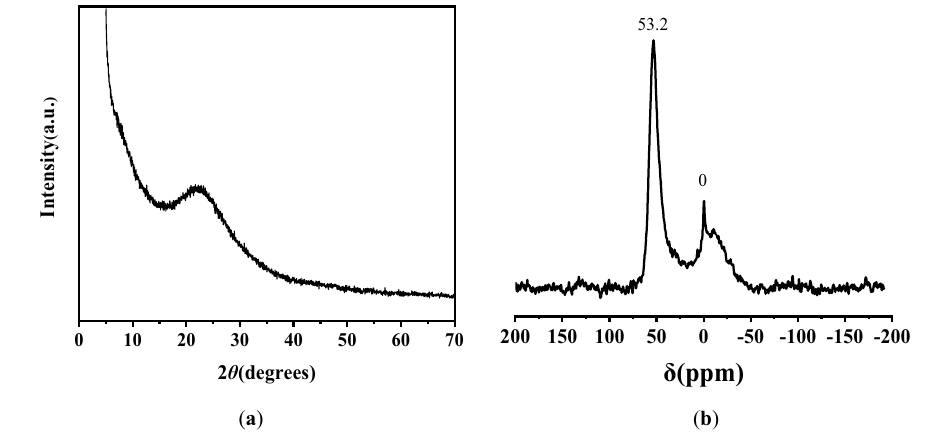
Figure 2: ( a ) XRD pattern of TUD - 1 and ( b ) 27 Al - NMR spectrum of TUD -